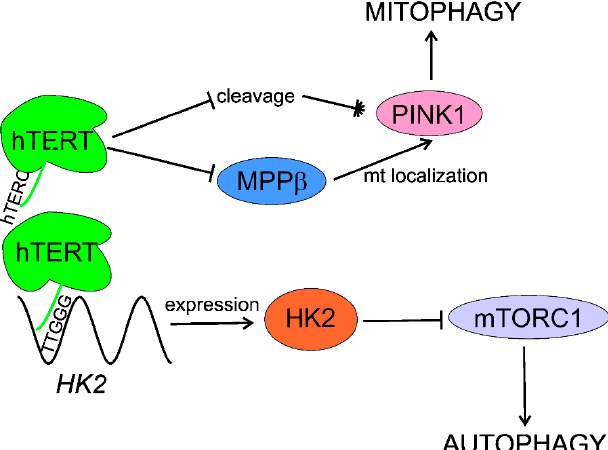
Figure 4. Telomerase stimulates macroautophagy (autophagy) and mitophagy. The RNA component of human telomerase (hTERC) binds the 5 (cid:48) -TTGGG-3 (cid:48) sequence within the promoter of the hexokinase 2 (HK2) gene, stimulating its expression. HK2 inhibits the mechanistic target of rapamycin complex 1 (mTORC1), which is a negative regulator of autophagy. The catalytic subunit of human telomerase (hTERT) negatively regulates cleavage of PINK1 (PTEN (phosphatase and tensin homolog) induced kinase 1) and assists its mitochondrial (mt) localization through inhibition of mitochondrial processing peptidase β (MPP β ), stimulating